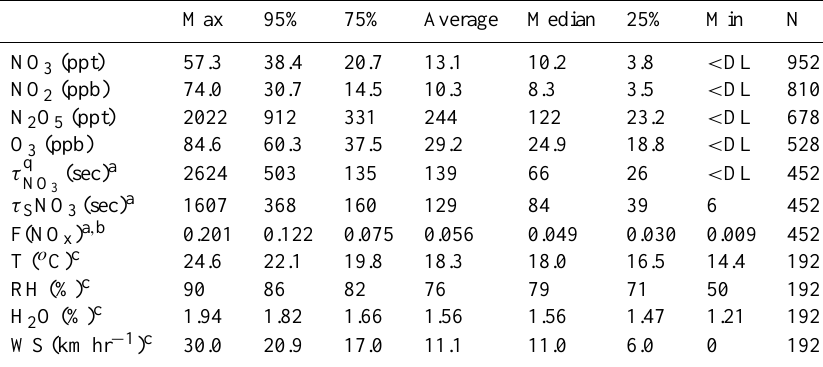
Table 1. Statistics for nighttime measurements at East Point (8:00 p.m.–8:00 a.m. PDT).